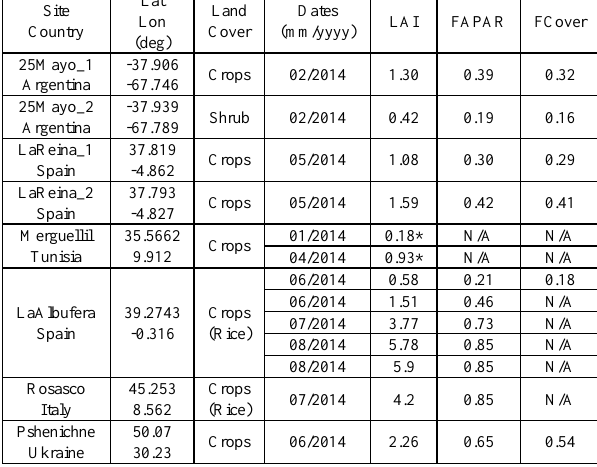
Table 1: Characteristics of the validation sites from ImagineS project for 2014 and associated ground biophysical